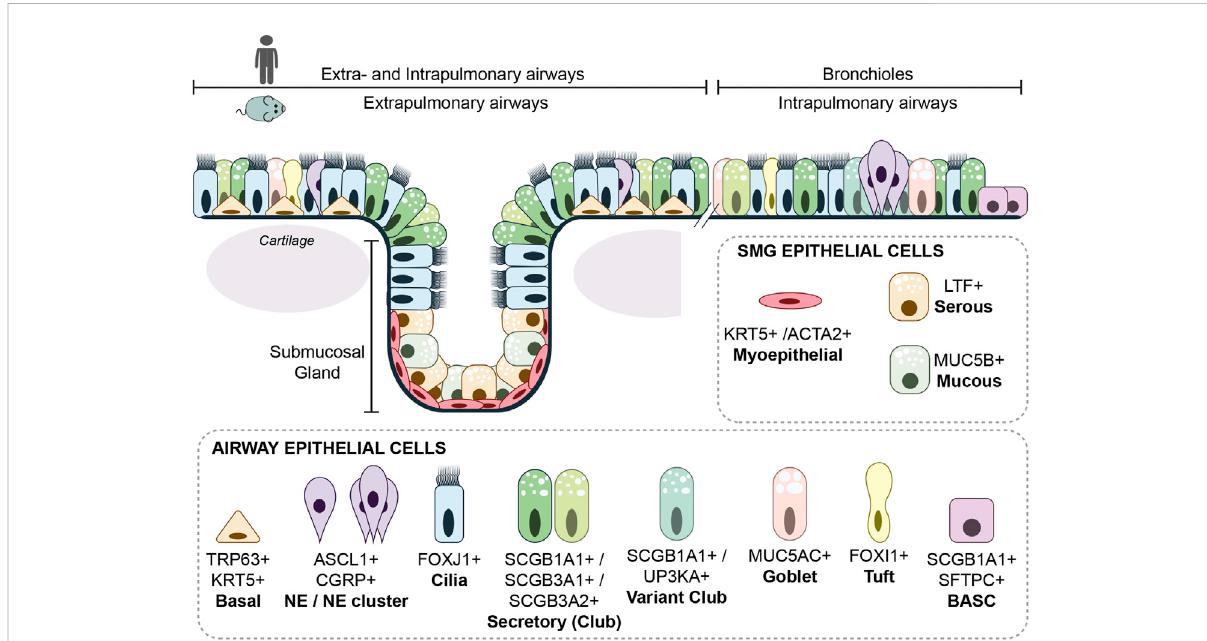
FIGURE 2 Cellular composition of the airways. The extrapulmonary epithelium (trachea and main bronchi) of the mouse consists of a pseudostrati fi ed epithelium containing basal cells, while in the human lung, basal cells are only absent in the bronchioles proximal of the alveoli. Submucosal glands are in mouse and human only present in cartilaginous airways. The airway epithelium consists of many different epithelial cells, the main epithelial cells are described within the text. A rare epithelial cell type is the ionocyte. Ionocytes appear to be the main source of cystic fi brosis transmembrane conductance regulator (CFTR) activity, thereby regulating mucous production (Montoro et al., 2018). Goblet cells are nearly absent in mouse airway epithelium, but are more frequently found in human airway epithelium and are together with other secretory cells, responsible for mucous